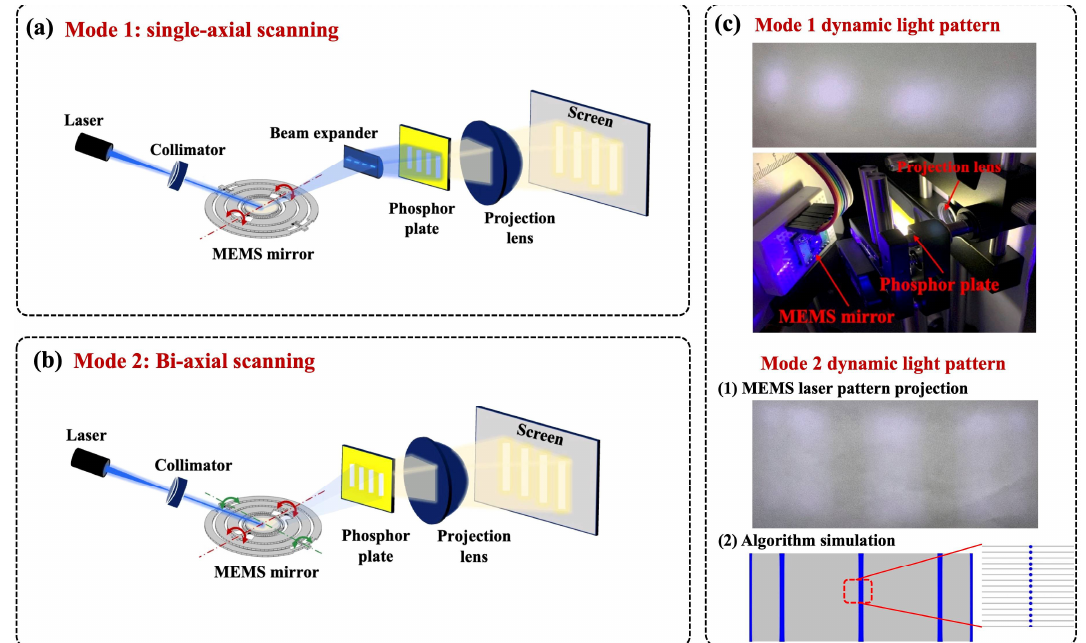
Figure 9. The schematic drawing of the laser headlight prototype optical system architecture with ( a ) 1D scanning mode and ( b ) 2D Lissajous mode. ( c ) The light patterns generated from ( a , b ) with experimental and simulation parameters, mode 1: f M = 17,328 Hz, N 1 = 4, L M 1 = 69,312 Hz, N f 1 = 4, mode 2: f x = 17,328 Hz, f y = 4810 Hz, N 2 = 8, L M 2 = 69,312 Hz, N f 2 = 5.